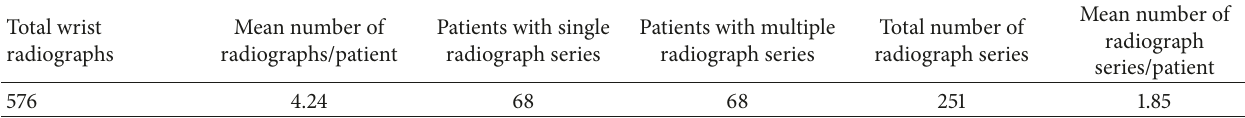
Table 2: Radiograph demographics.